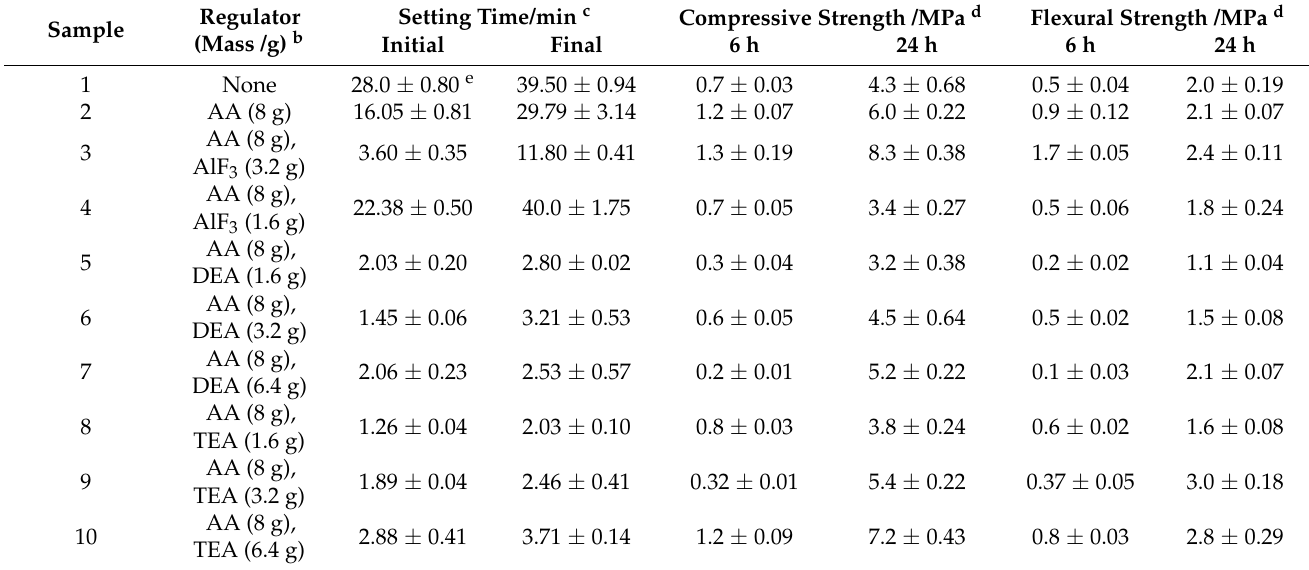
Table 1. Setting time of the cement and mechanical strength of mortar under different regulator loadings a